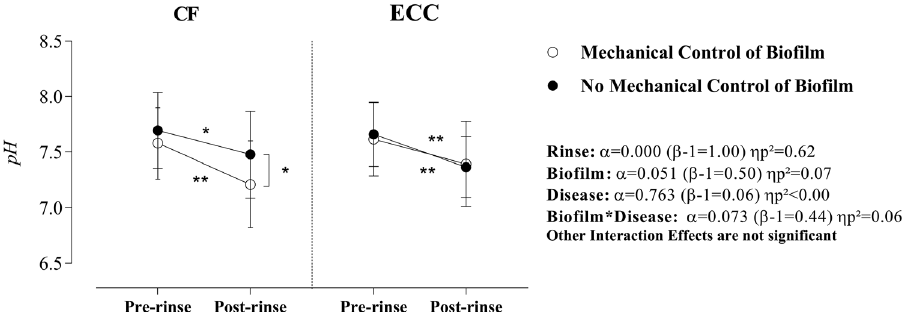
Figure 2. Effect of rinse, mechanical control of biofilm, and disease on saliva pH. Statistical analyses were performed in a sample of 56 volunteers, 28 per group. ηp 2 : Partial eta squared. Data plotted as mean and standard deviations (due to Gaussian distribution). Non-significant interactions were suppressed. A single asterisk represents a significant p-value ≤ 0.05. A double asterisk represents p-value ≤ 0.01. Simple effects for Rinse in CF children—Mechanical control of biofilm: α = 0.000 (β-1 = 1.00) ηp 2 = 0.45 and No mechanical control of biofilm: α = 0.005 (β-1 = 0.82) ηp 2 = 0.14). Simple effects for Rinse in children with ECC—Mechanical control of biofilm: α = 0.000 (β-1 = 0.97) ηp 2 = 0.23 and No mechanical control of biofilm: α = 0.000 (β-1 = 0.97) ηp 2 = 0.23. Simple effects for Biofilm in CF children—Pre-rinse: α = 0.12 (β-1 = 0.35) ηp 2 = 0.05 and Post-rinse: α = 0.01 (β-1 = 0.75) ηp 2 = 0.12. Simple effects for Biofilm in children with ECC—Pre-rinse: α = 0.54 (β-1 = 0.09) ηp 2 = 0.007 and Post-rinse: α = 0.78 (β-1 = 0.06) ηp 2 = 0.001. Simple Effects for Disease: No significant